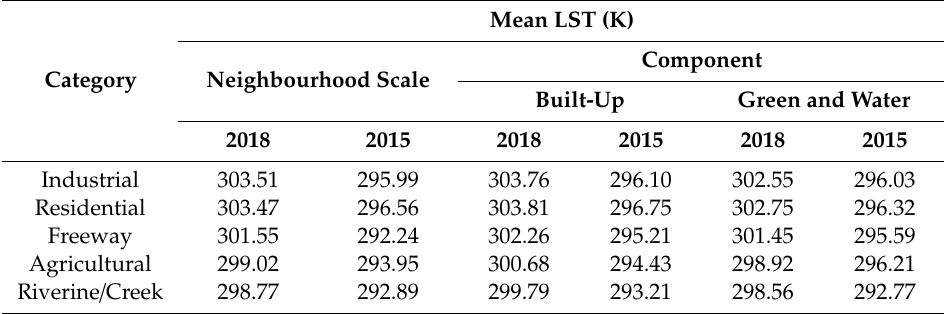
Table 8. Dynamics of the mean LST in the scale of neighbourhood and composition.